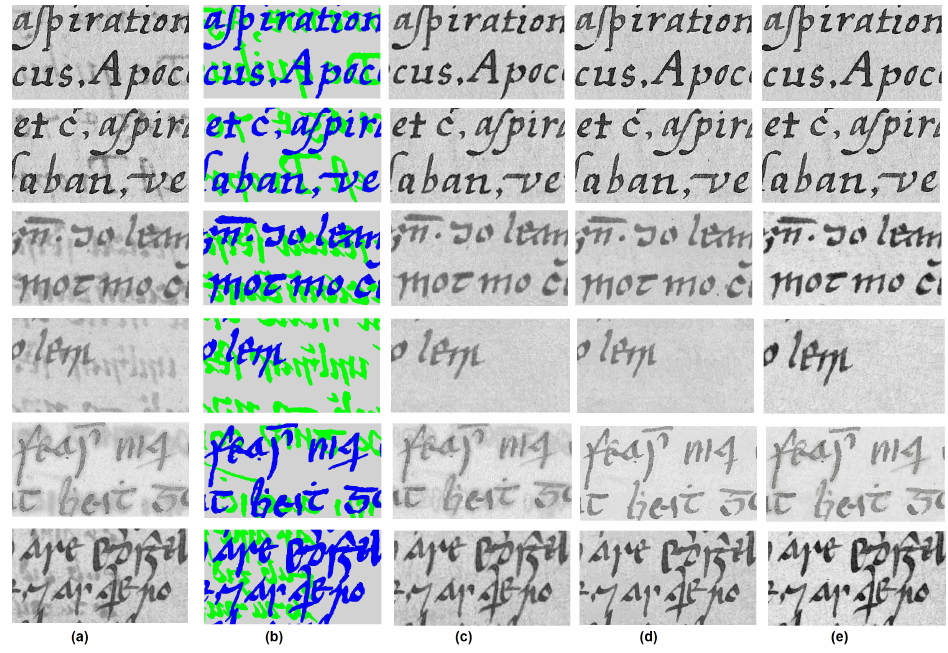
Figure 3. Visual comparison of bleed-through restoration. ( a ) input degraded image; ( b ) hand labeled ground truth image; ( c ) restored image by [16]; ( d ) restored image by [7]; ( e ) restored image by the proposed method.